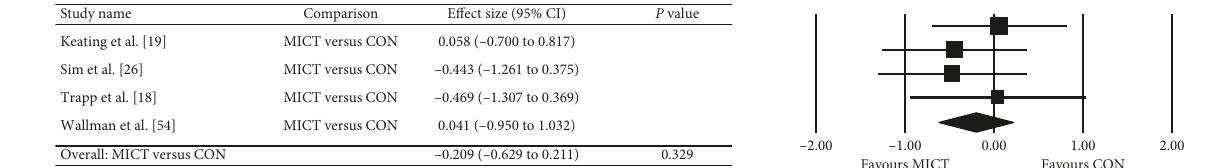
Figure 4: Effect of MICT versus CON on energy intake. MICT: moderate-intensity continuous training, CON: control, and CI: confidence Table 3: Metaregression of the pooled effect of comparisons of HIIT/SIT versus MICT on energy intake (kJ) by characteristics of studies. Comparison